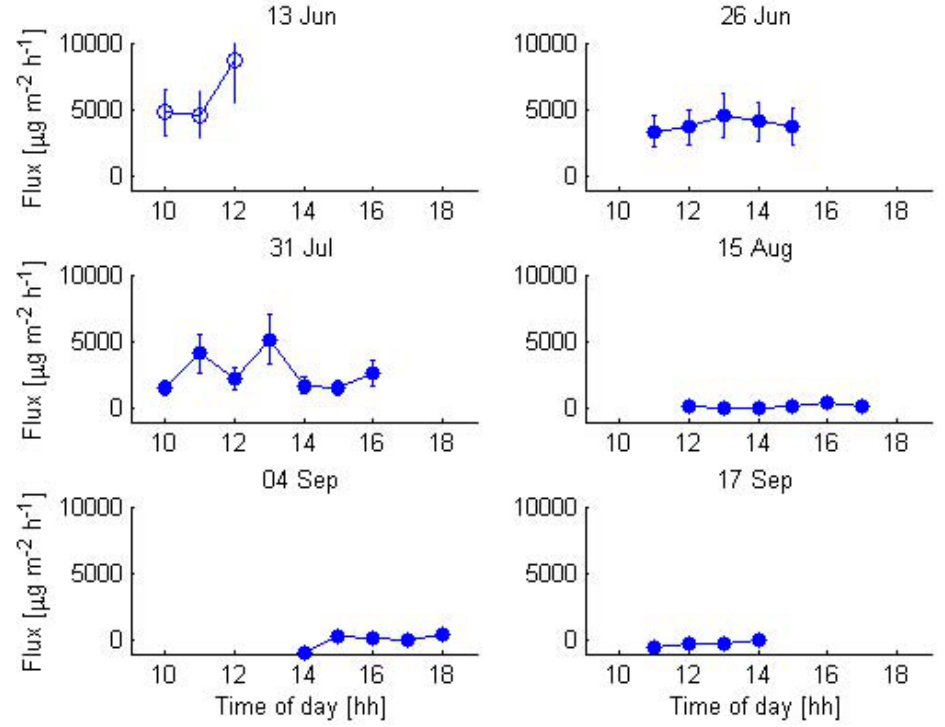
Fig. 2. Ecosystem scale monoterpene fluxes measured using disjunct eddy accumulation (DEA) between 13 June and 17 September, 2008. The data from 13 June were discarded from further analyses due to corrupted wind measurement and are shown here by open circles.